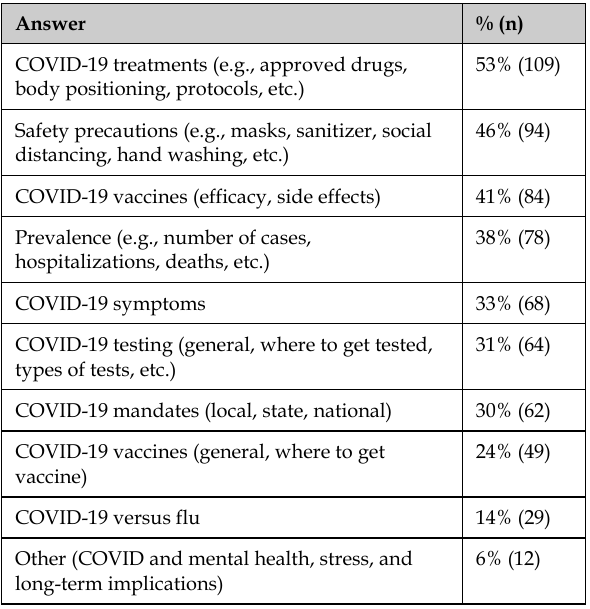
Table 5 Factors impacting reference services during